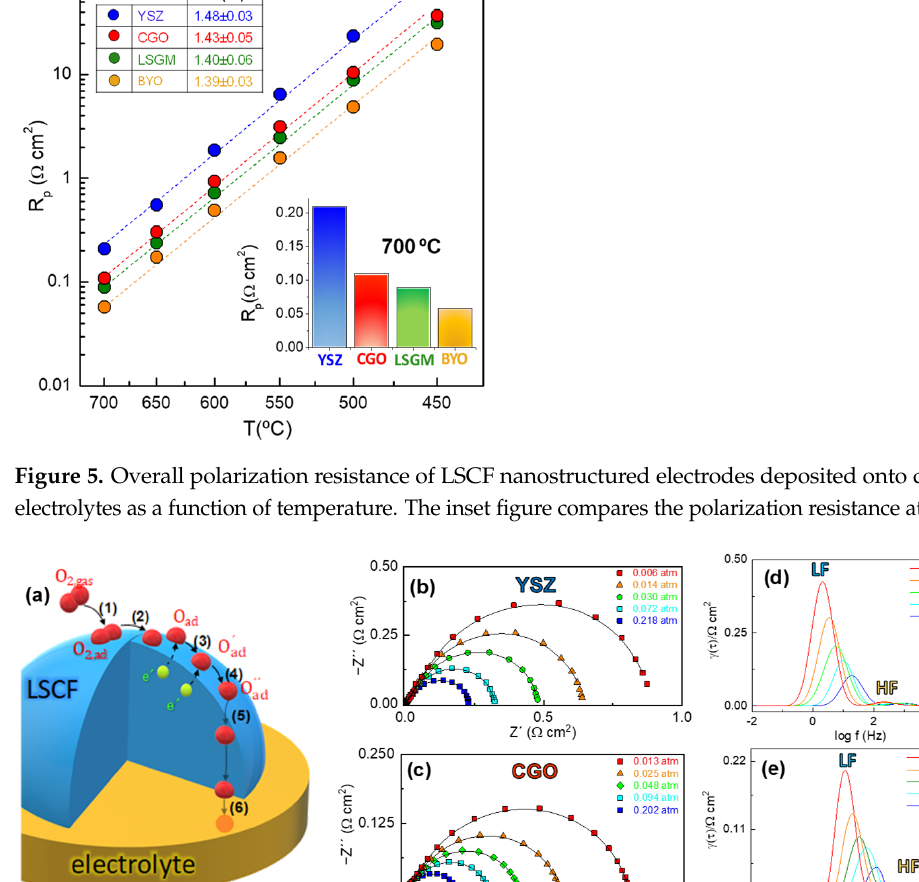
Figure 6. ( a ) Schematic diagram of the different sub-reactions of the oxygen reduction reaction. Impedance spectra at 700 ◦ C of ( b ) LSCF/YSZ/LSCF and ( c ) LSCF/CGO/LSCF cells as a function of the oxygen partial pressure and the corresponding ( d , e ) DRT plots.